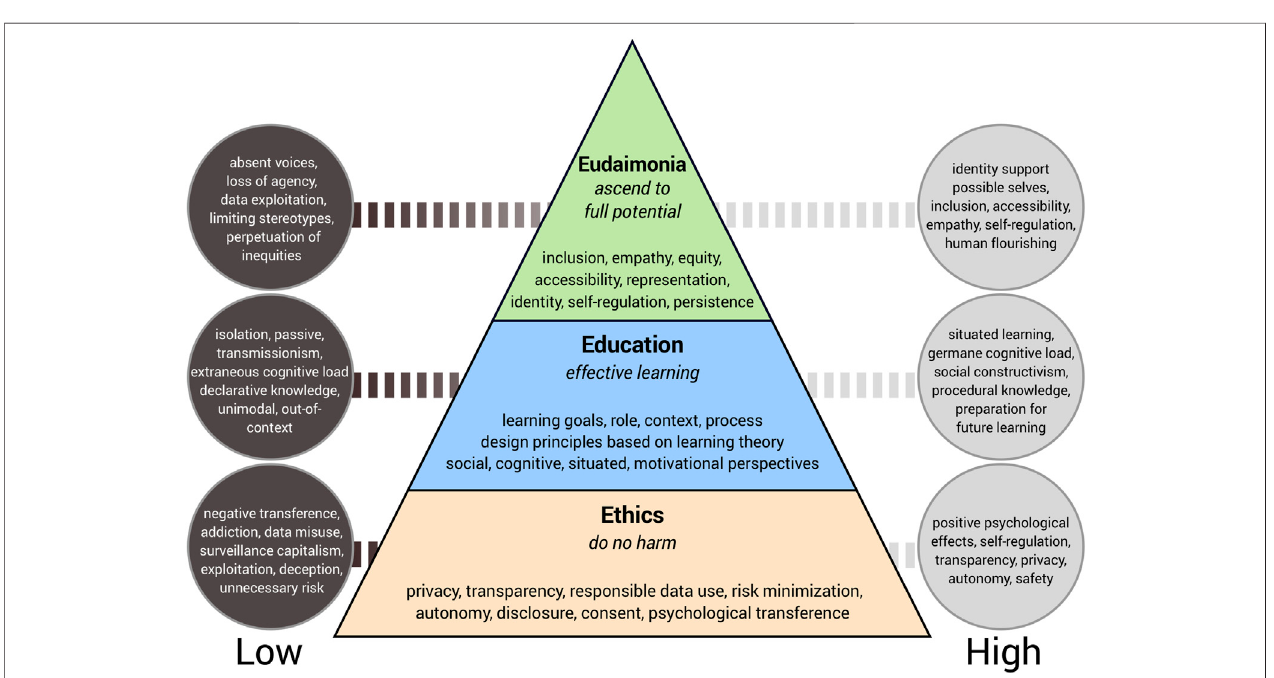
FIGURE 4 | Expanded E3XR framework with